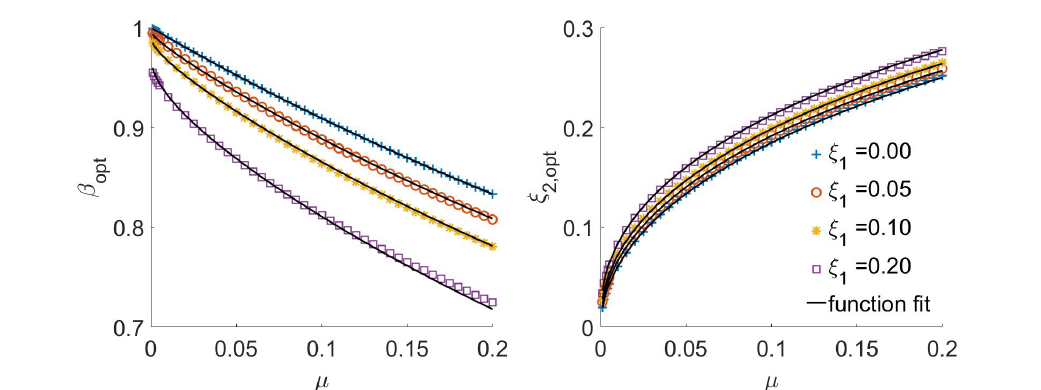
Figure 5. Optimum TMD parameters: TF No.